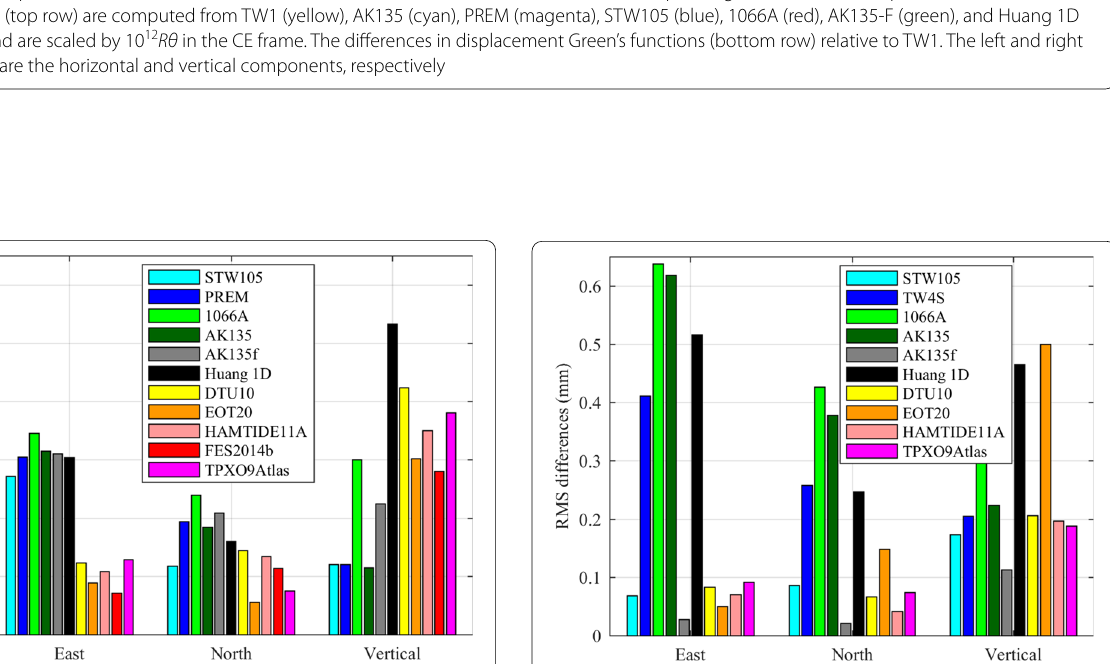
Fig. 11 RMS differences of the modeled M 2 OTL displacements between different model combinations. The RMS differences of the modeled M 2 OTL displacements are computed between different ocean tide models and FESJB (the Earth model is TW1), as well as between different Earth models and TW1 (the ocean tide model is FESJB)